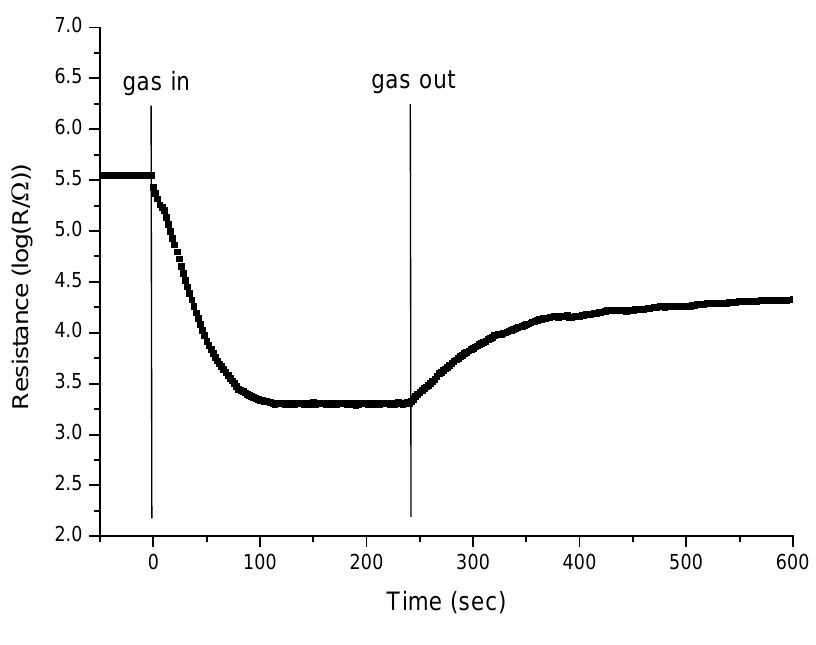
Figure 7. Transient response curves to 600ppm H2 at 320oC of the SiO2 coated F-doped SnO2 sensor.